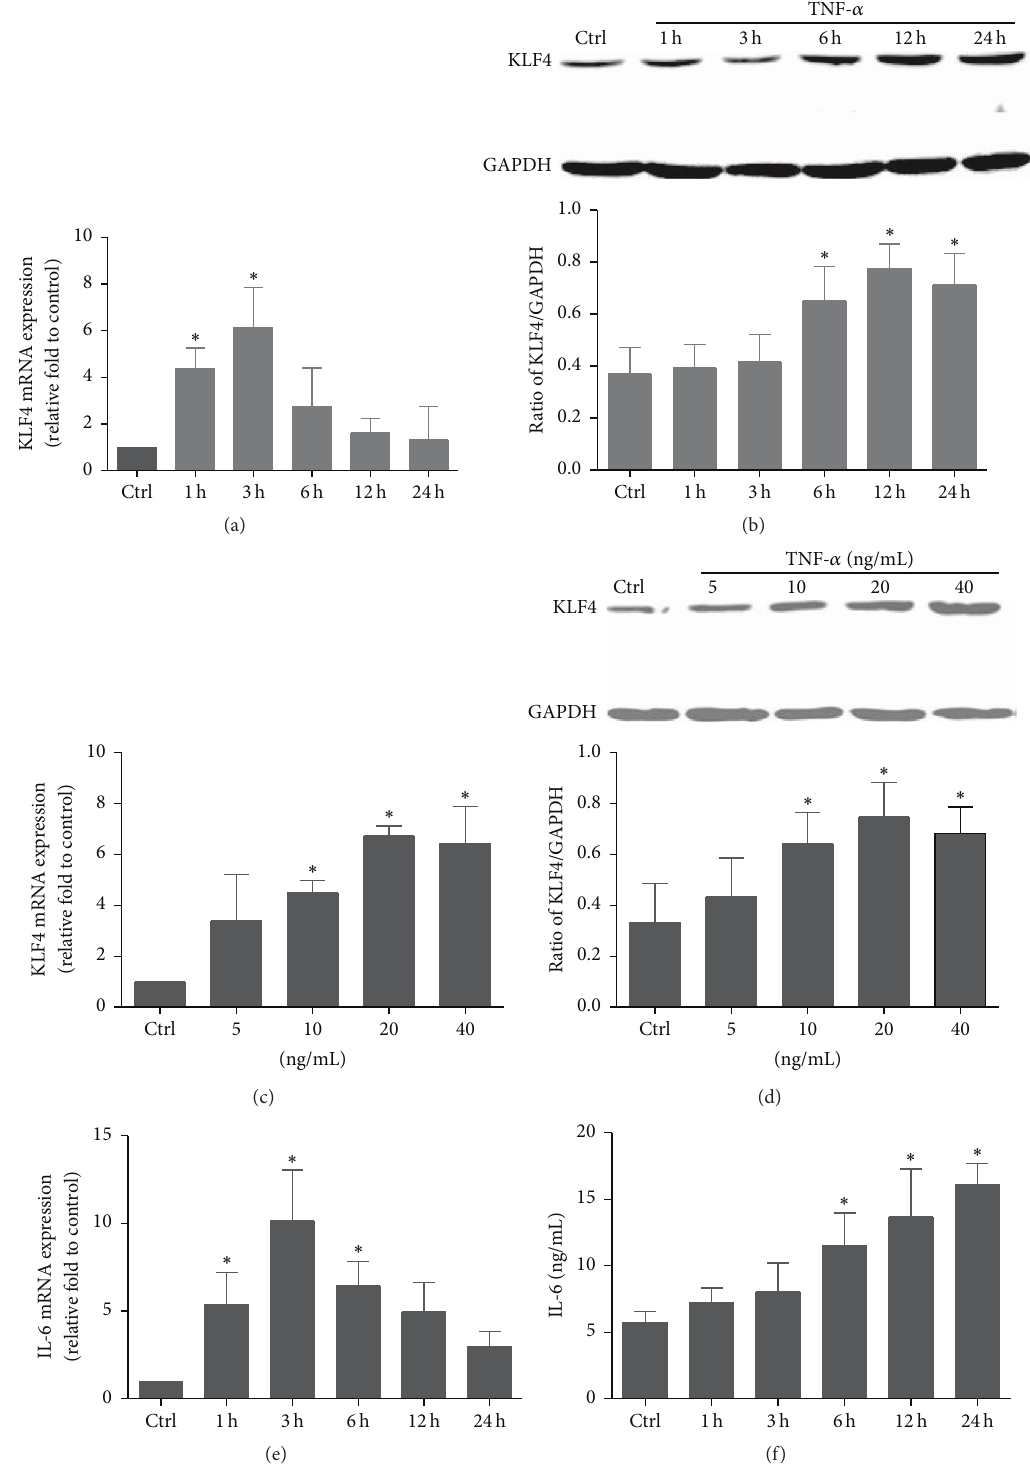
Figure 2: Expression of KLF4 and IL-6 in RA FLSs in response to TNF- 𝛼 . KLF4 is induced by TNF- 𝛼 in a time- and dose-dependent fashion. RA FLSs were incubated with 20 ng/mL TNF- 𝛼 for the indicated time periods, and expression of KLF4 was assessed by real-time PCR (a) and western blotting (b). RA FLSs were incubated with TNF- 𝛼 at different doses, and expression of KLF4 was assessed by real-time PCR after 3 h (c) and western blotting after 12h (d). The lower panels in (b) and (d) indicate the ratio of KLF4/GAPDH protein. Time course of RA FLS IL-6 expression in response to 20ng/mL TNF- 𝛼 was assessed by real-time PCR (e) and ELISA (f). GAPDH as an endogenous control. Data were expressed as means ± SEM ( 𝑛 = 3 ); ∗ 𝑃 < 0.05 in comparison to the untreated cells